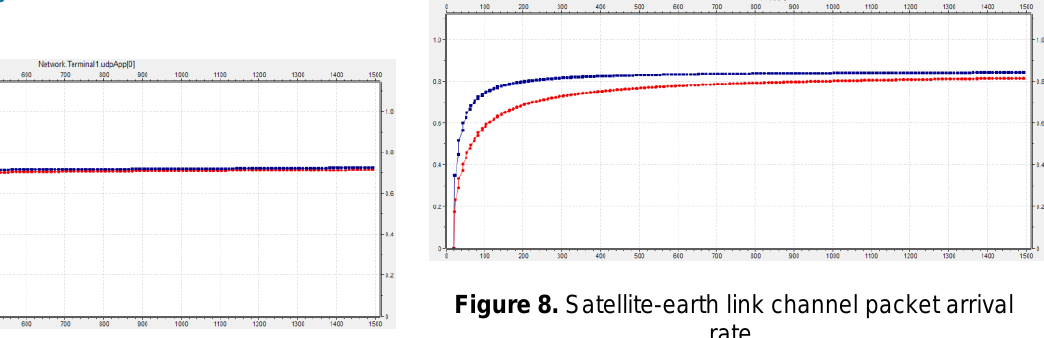
Figure 5. Free space channel packet delay.